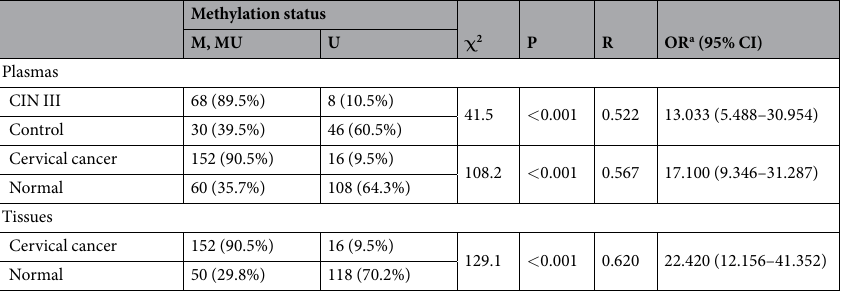
Lastly, we demonstrated that MEG3 methylation in plasma was a prognostic factor for cervical cancer patients. Together, these results were to identify the clinical significance of plasma MEG3 methylation in cervical cancer. Results Reliability of MEG3 methylation in plasma.